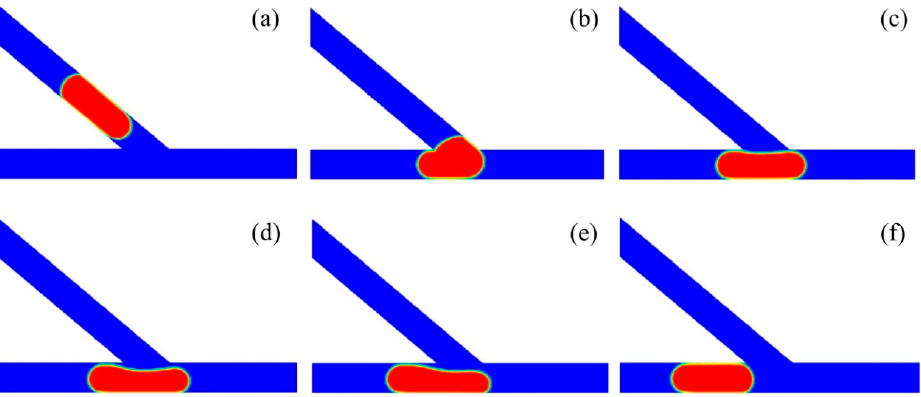
Figure 8. Passive sorting of droplet into the left channel at a relatively large velocity of U = 10 mm/s ( θ = 40°, V d / w 3 = 2). ( a ) T0, ( b ) T1 = T0 + 2.55, ( c ) T2 = T0 + 3.25, ( d ) T3 = T0 + 3.75, ( e ) T4 = T0 + 4.65, ( f ) T5 = T0 + 6.05.